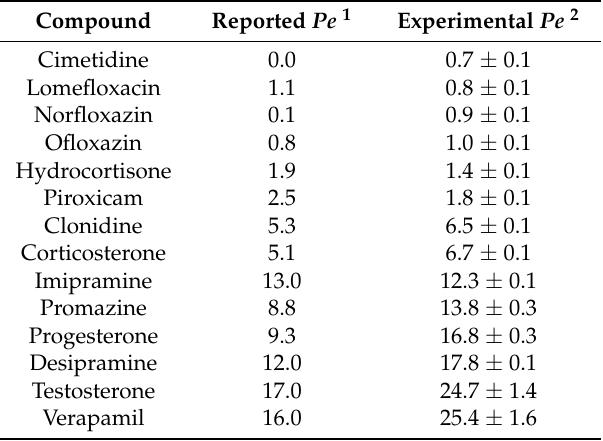
Table 2. Experimental and reported BBB permeability ( Pe 10 − 6 cm s − 1 ) values of the commercial drugs used for assay